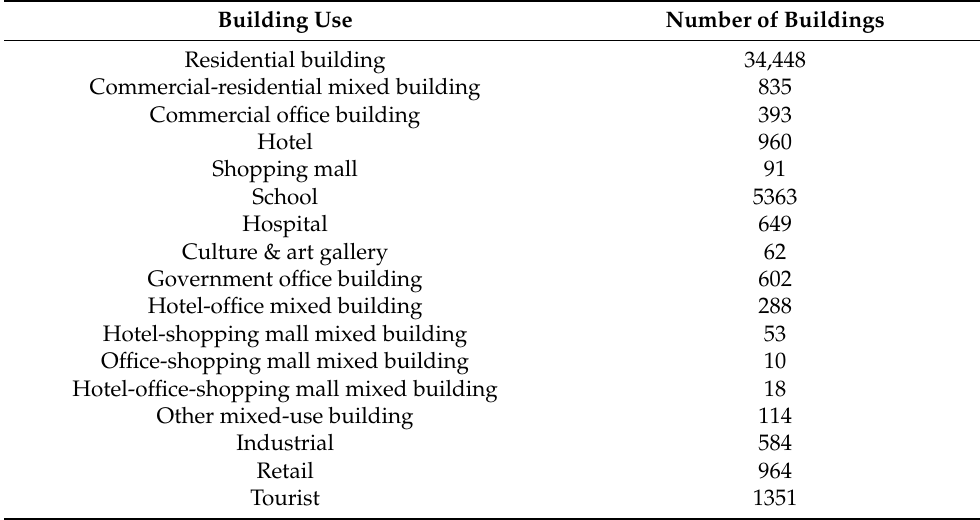
Table 5. Primary building use determination